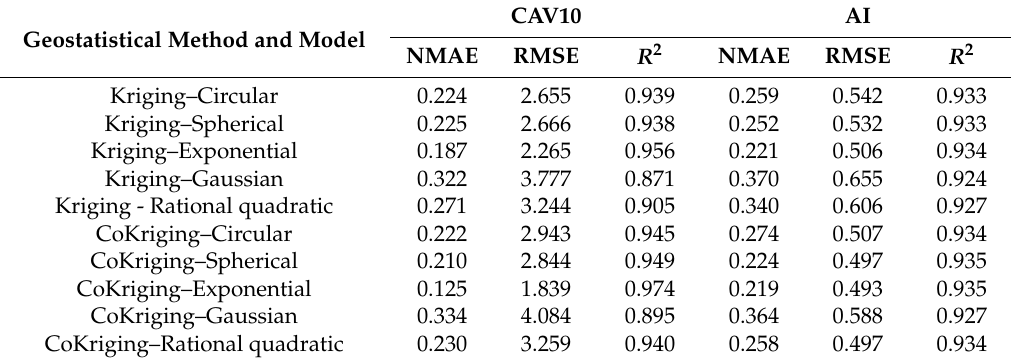
Table 2. Indexes to assess accuracy of geostatistical prediction models for M W 6.5 Norcia earthquake.